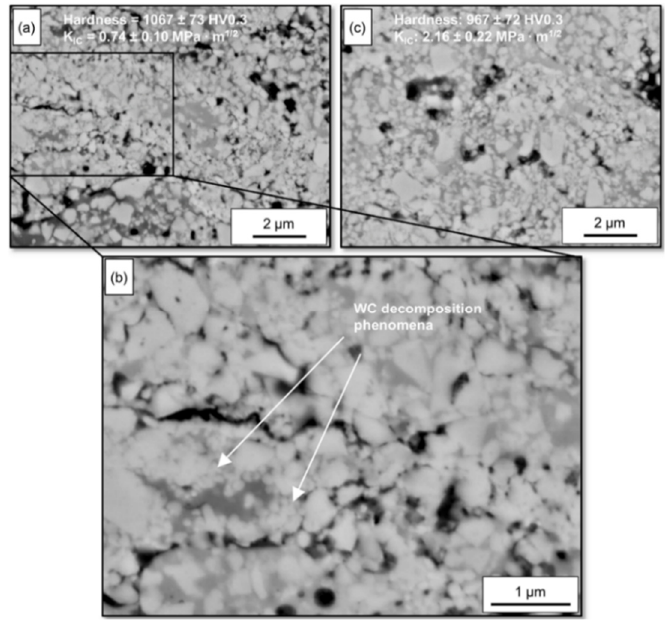
Figure 4. SEM images taken at the cross-section showing the BSE imaging of different WC-CoCr coatings: ( a , b ) using a decreased oxy-fuel ratio, and ( c ) using an increased oxy-fuel ratio. A certain number of polygonal-shaped WC particles changed into globular clusters.